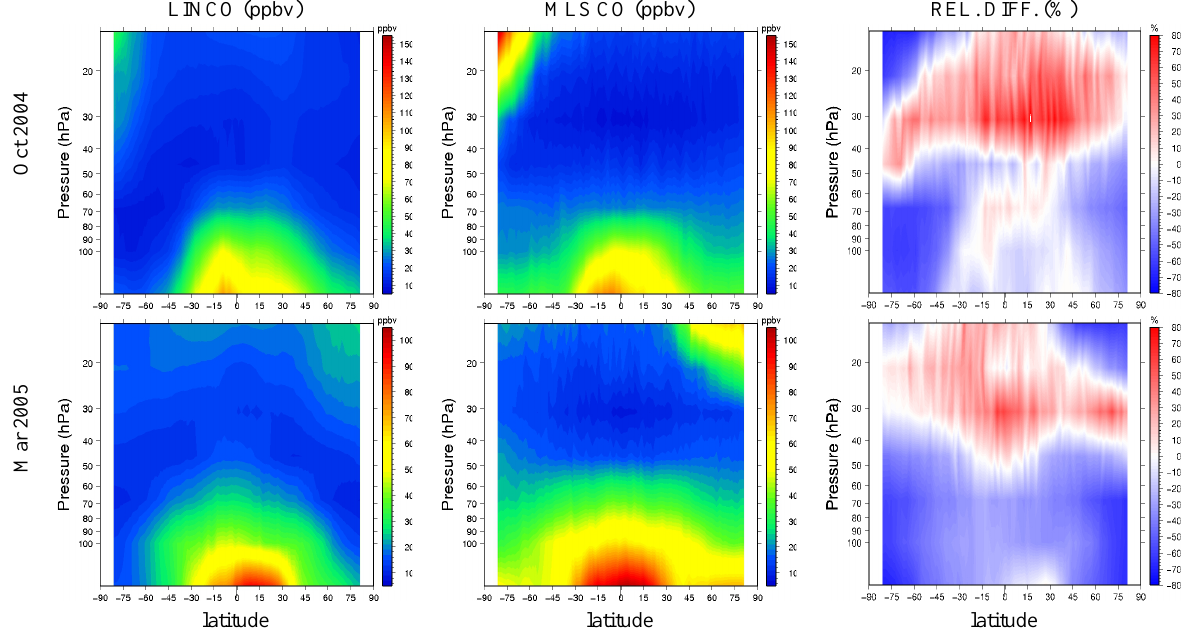
Fig. 7. Zonal monthly mean of CO from LINCO (left) and MLS (middle) in parts per billion by volume (ppbv) and corresponding relative differences (%) (right) for October 2004 (upper panel) and March 2005 (lower panel). Pressure levels are selected from 146 to 14hPa. Note that LINCO mixing ratios have been smoothed by triangular MLS averaging